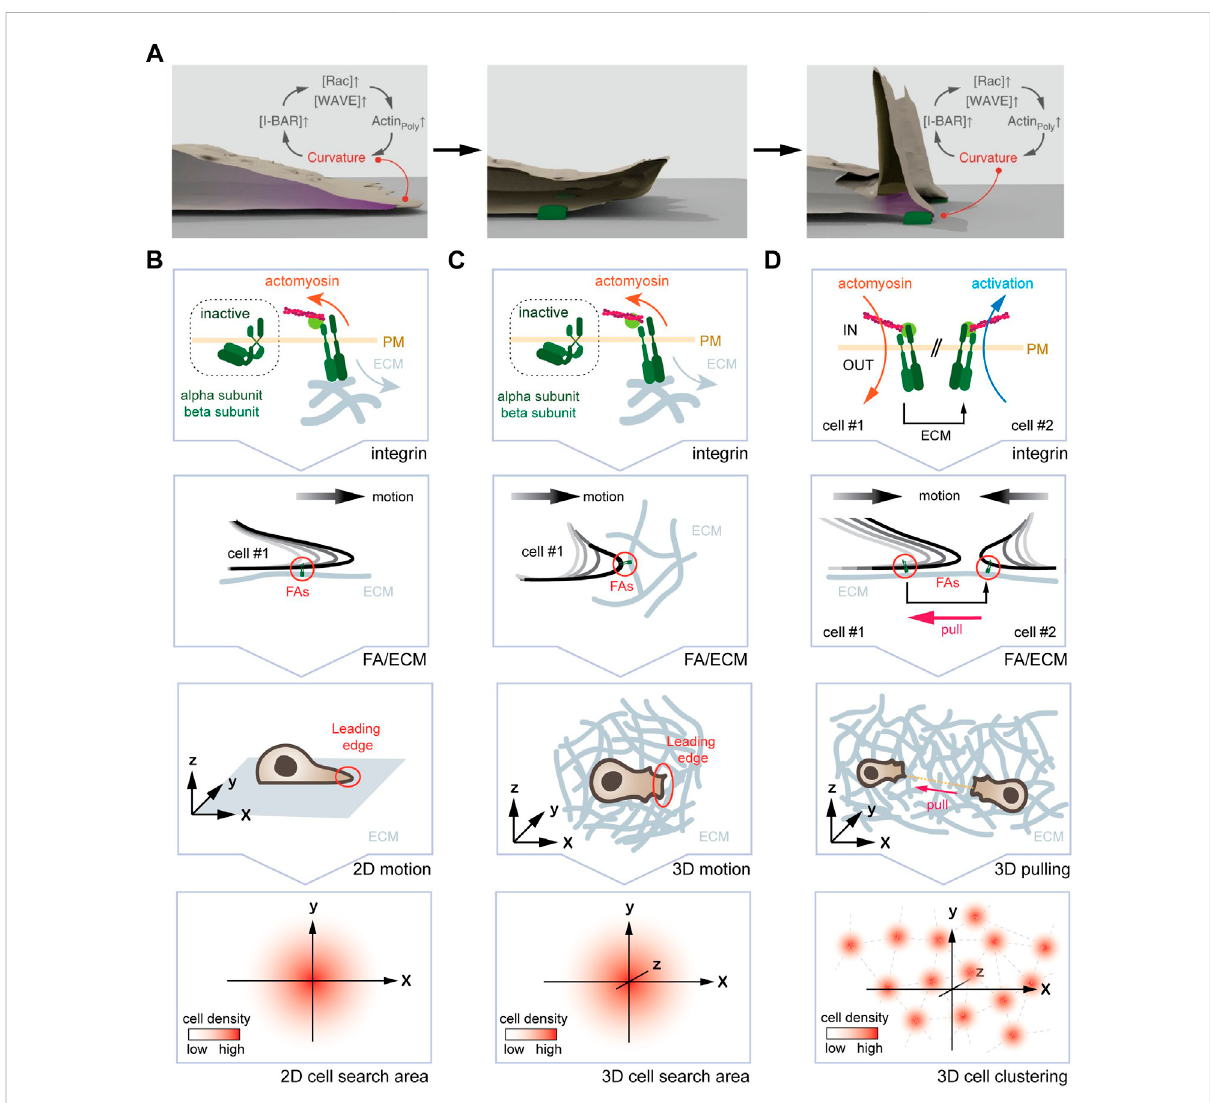
FIGURE 3 One curvature-dependent self-organizing circuit yields different emerging properties for mesenchymal cells plated in 2D and 3D. (A) Self- organizingLEre-initiationcircuitin2D.HighlocalcurvaturetriggersI-BARdomainproteinenrichment,whichfurtherpromotesactinpolymerization and protrusion formation. Upon retraction, adhesion of FAs (green) to the ECM leads to a local high plasma membrane curvature, promoting I-BAR protein enrichment, increased actin polymerization, and LE re-initiation. (B) From the molecular clutch to motion pattern in 2D. From top to bottom,engagementofthemolecularclutchleadstotheactivationofthecurvature-dependentfeedback-loopattheLE.Thearisingmotionpattern displays an augmented persistence, which manifests in an increased search ef fi ciency due to lower oversampling of the same areas. (C) From the molecular clutch to motion pattern in 3D. From top to bottom, engagement of the molecular clutch, the resulting deformation of the LE, and the arising motion pattern are shown. Again, an increase in persistence time augments the search ef fi ciency. (D) Hypothetical mechanism for the formation ofcell clustersin3D.Fromtoptobottom,engagement ofthemolecular clutchintwoadjacent cellsisshown.Here, onecellpulling atthe ECM will cause inverse membrane deformations in an adjacent cell. This, in turn could activate the self-organizing feedback loop causing cell assembly. Image in (A) modi fi ed with permission from Begemann et al.,